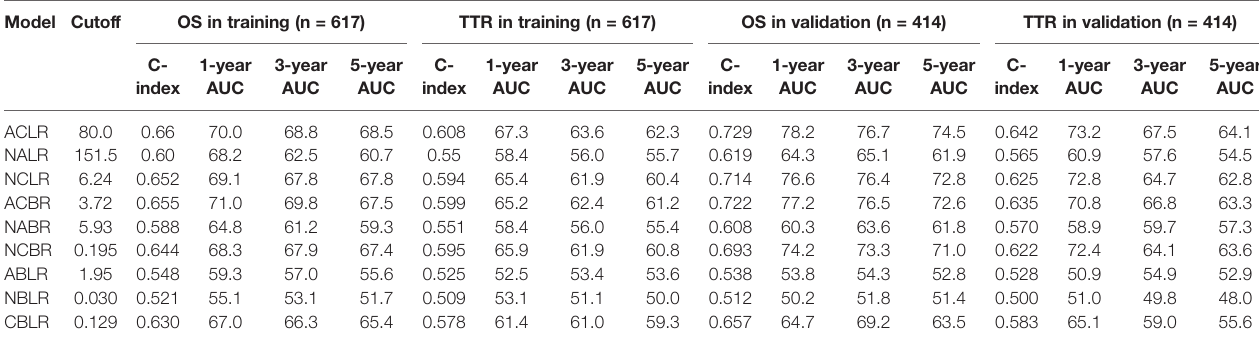
TABLE 1 | C-indexes and AUCs of the nine models in the training and validation cohort. Model